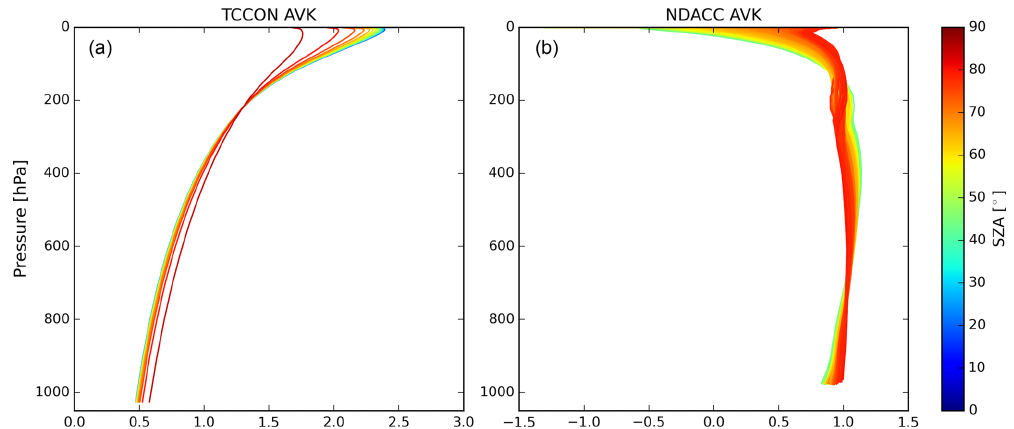
Figure 2. The typical N 2 O column averaging kernel of TCCON (a) and NDACC (b) at Réunion. The different colors correspond to different